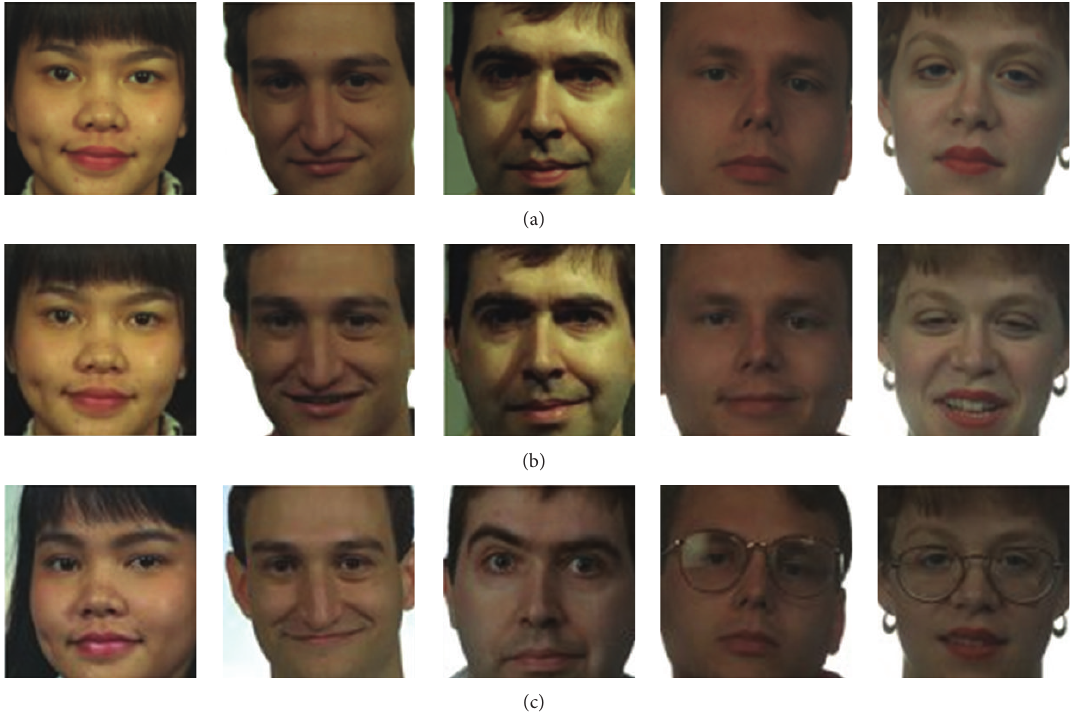
Figure 8: Some sample images of the subsets of (a) fa, (b) fb, and (c) dup1 of the color FERET database.